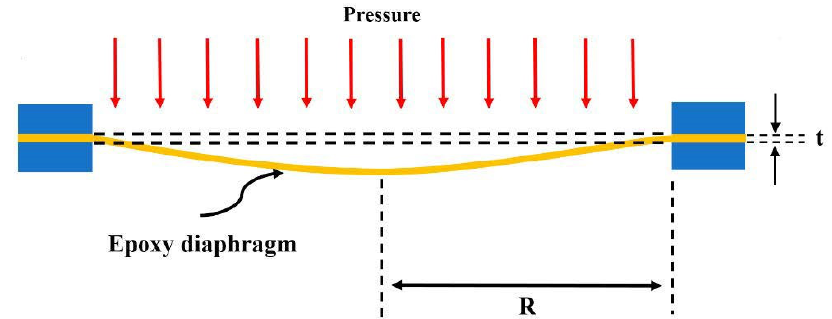
Figure 2. Deformation of a circular diaphragm subjected to an uniform pressure.